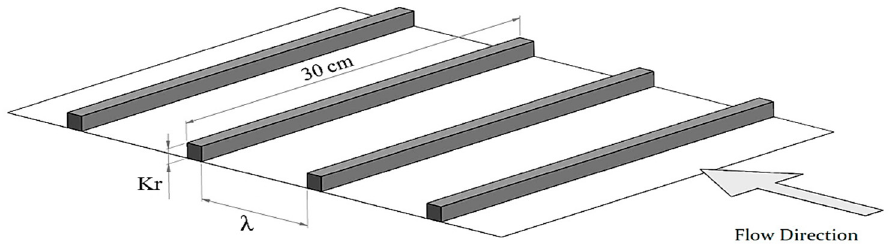
Figure 4. Sketch of the configurations of the roughness arrays.